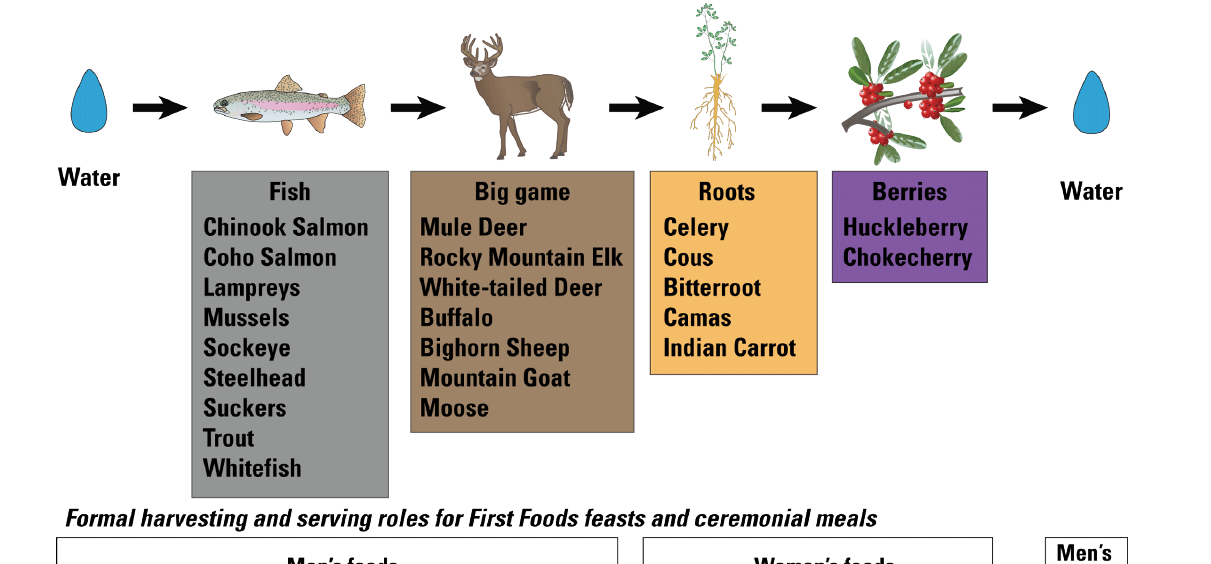
Fig. 3 . An example of the serving order of the Confederated Tribes of the Umatilla Indian Reservation. Foods are served in the order in which foods promised to care for the tribal people. This serving order includes some examples of culturally significant First Foods, but is not a comprehensive table setting. For First Foods feasts and other ceremonial meals, men harvest the fish and big game and serve the water, fish, and big game while women harvest and serve the roots and berries. These harvest gender roles are not strictly followed during other times of the year, such as when harvesting for familial and personal use. Images courtesy of the Integration and Application Network, University of Maryland Center for Environmental Science (http://ian.umces.edu/